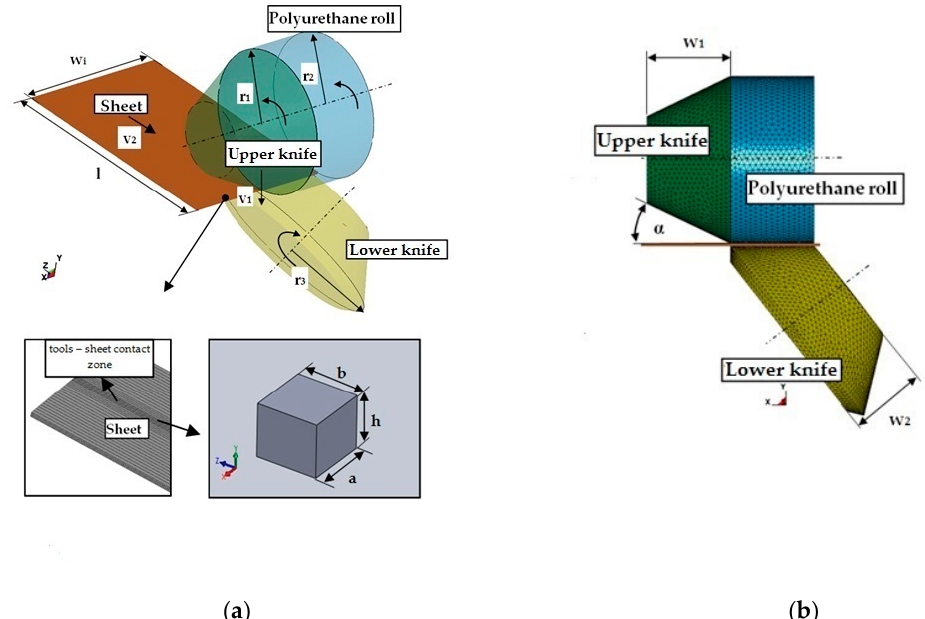
Figure 3. FEM simulation model of the shear-slitting process: ( a ) Isometric view with discretization of sheets scheme; ( b ) Front view. Table 1. Mechanical and magnetic properties of ET 122-30 steel (at T = 20 °C).